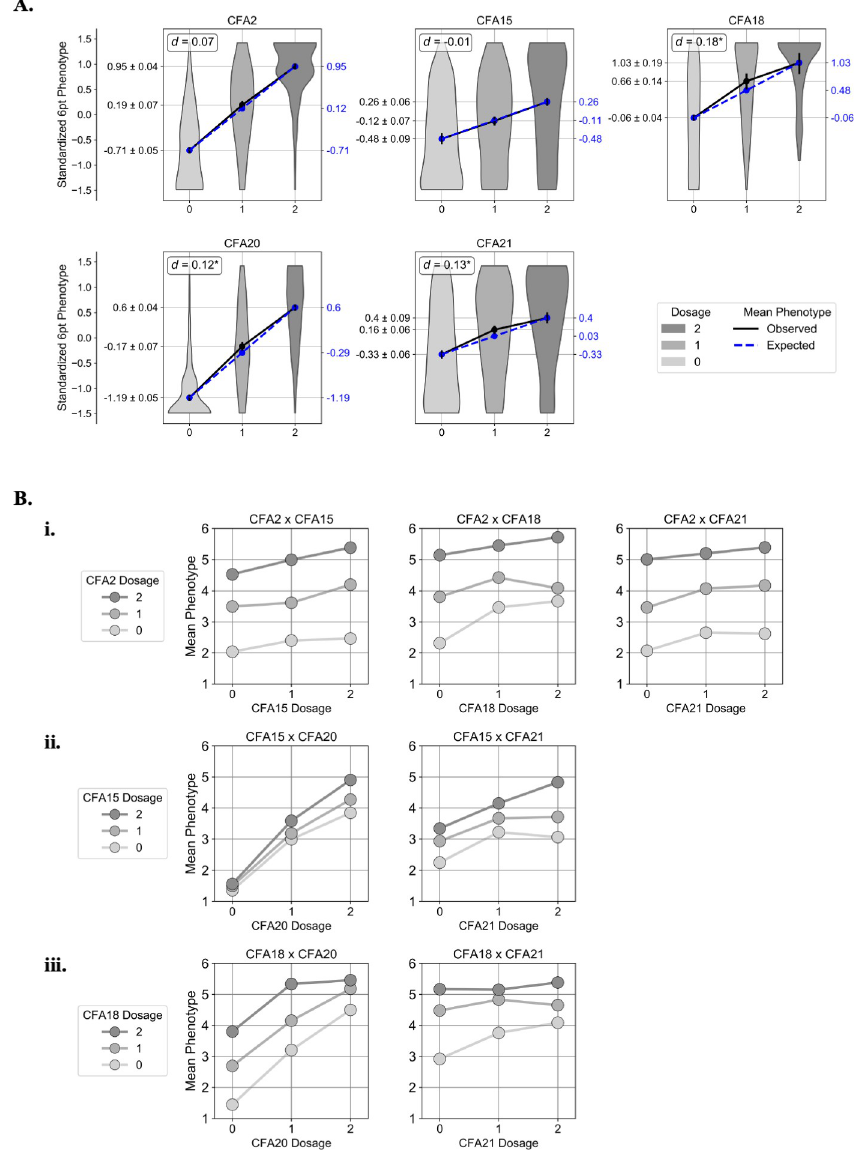
Fig 4. Dominance and epistatic interactions. A. For each of the top five GWAS markers, violin plots show the distribution of observed normalized six point phenotype values for each genotype class. The black lines connect the observed means of the three genotype classes, and the blue lines connect the expected means under a perfectly additive model. The estimated dominance coefficient for each marker, d , is shown in the upper left hand corner of each plot. An asterisk indicates that the predicted heterozygote class mean phenotype fell outside the 95% confidence interval of the observed heterozygote mean phenotype, which we interpret to mean that d is statistically significant. B. Scatter plots showing genotype-phenotype interactions at the seven locus pairs that showed statistically significant interaction effects per the epistasis test. In each plot, the “dosage”, i.e. the diploid genotype coded as the number of red-associated alleles, is displayed on the X axis, and the dosage at the other marker is represented by the three lines connecting the points. The Y axis shows the mean six point coat pheomelanin intensity phenotype across dogs with each genotype